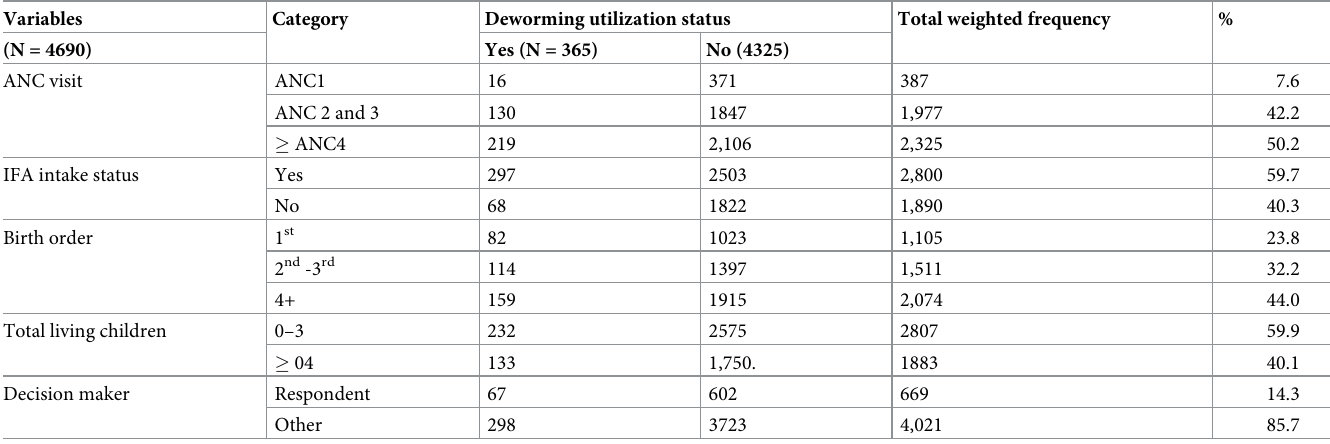
Table 2. Maternal characteristics result of respondents in 2016 EDHS,